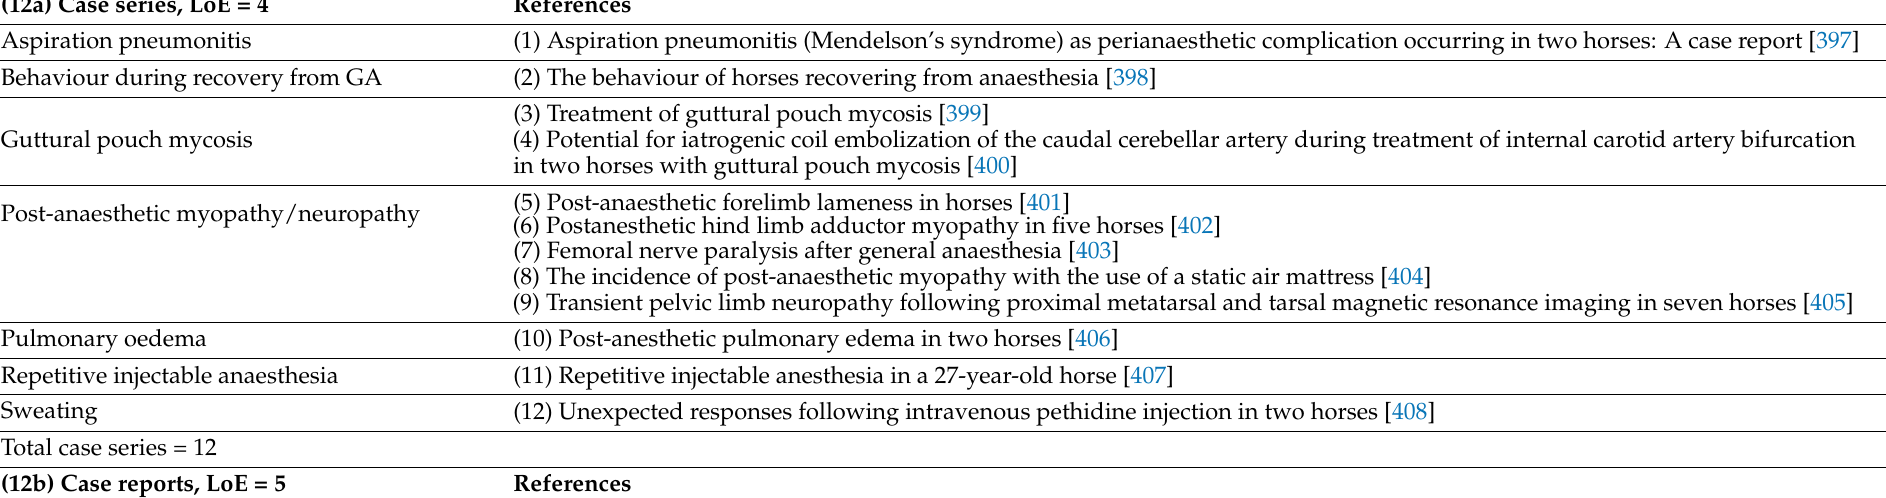
Table 12. Total of: (12a) “ case series ” and (12b) “ case reports ” giving information about the recovery period, mainly complications that may happen during this phase. (12a) Case series, LoE =